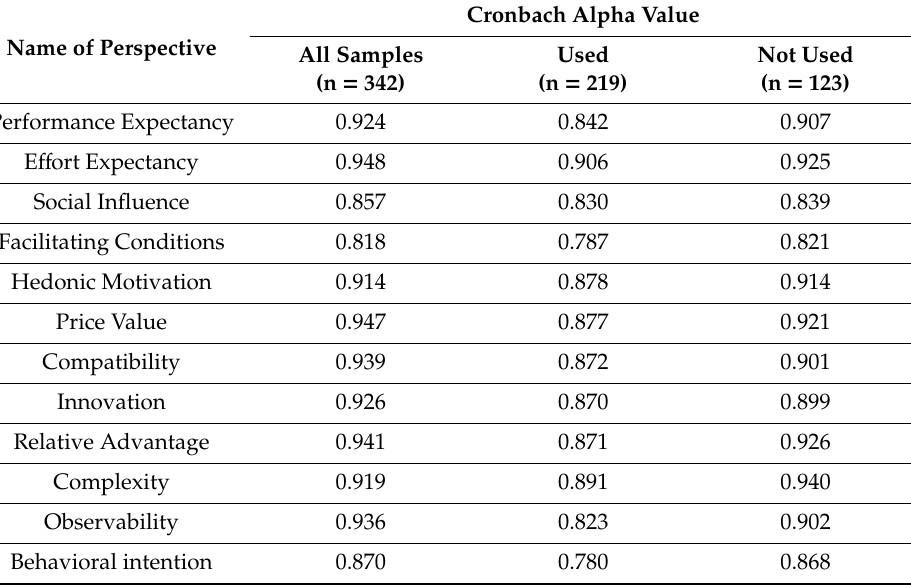
Table 2. Perspective reliability analysis.